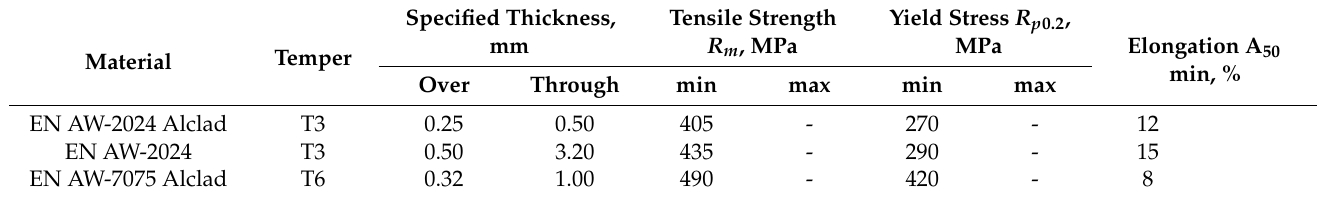
Table 2. Basic mechanical properties of test sheets [36].